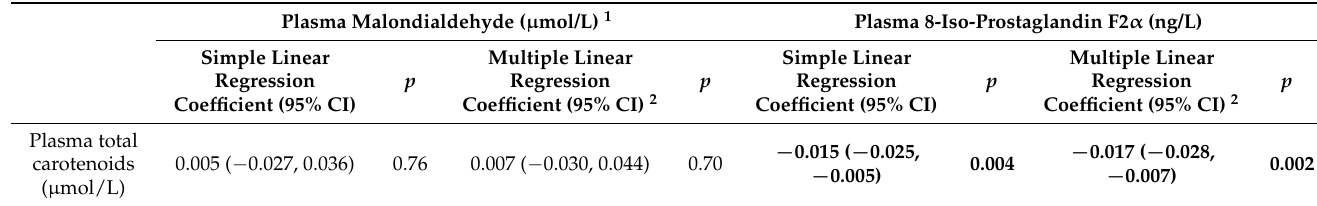
Table A3. Associations between absolute change values of plasma carotenoids concentration and skin carotenoids status with corresponding changes in the biomarkers of oxidative stress for combined study